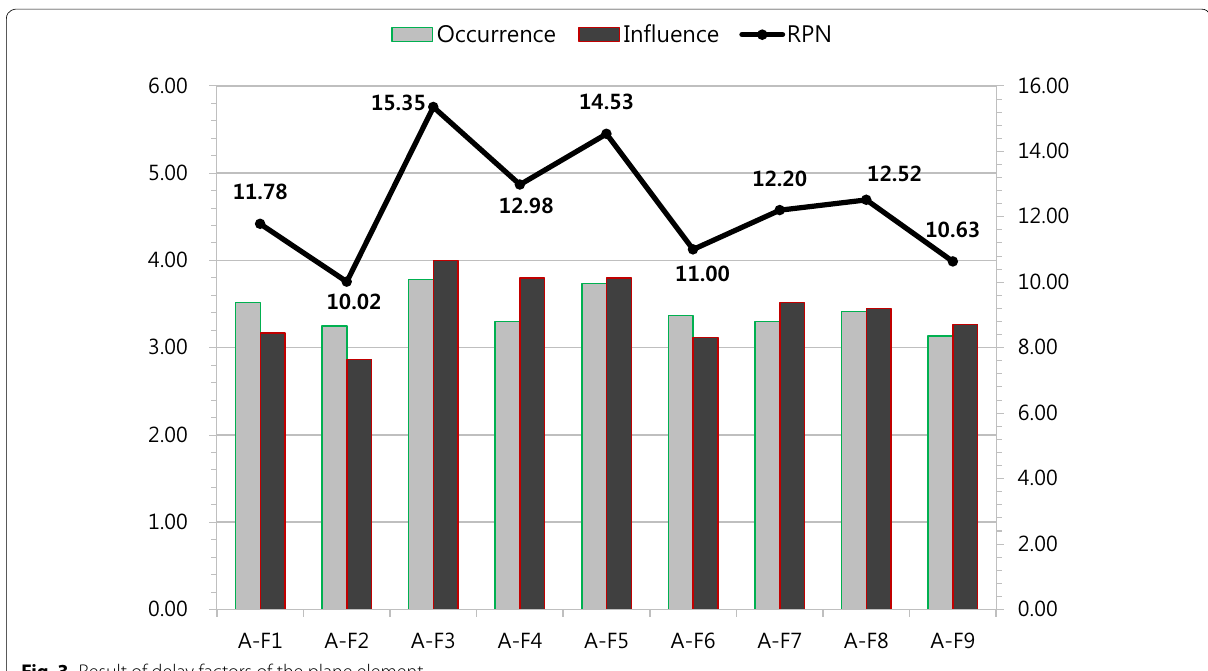
Fig. 3 Result of delay factors of the plane element.